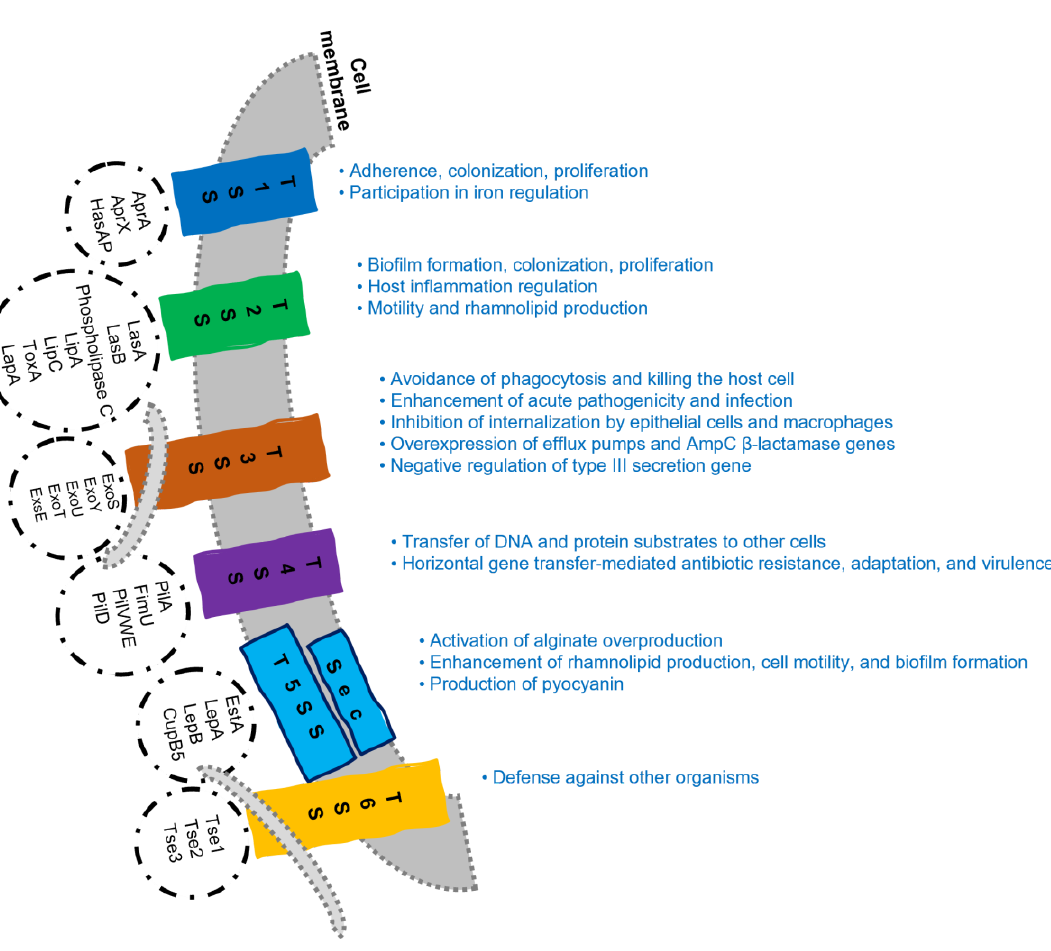
Figure 1. Schematic representation of P. aeruginosa secretion systems (T1SS to T6SS) and their functions (original).